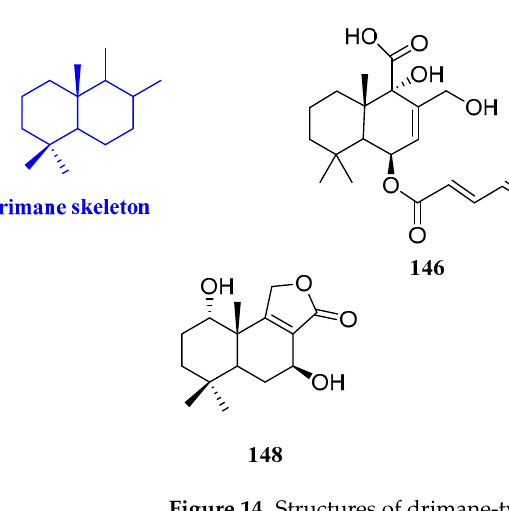
Figure 14. Structures of drimane - type sesquiterpenoids 146 − 149 .